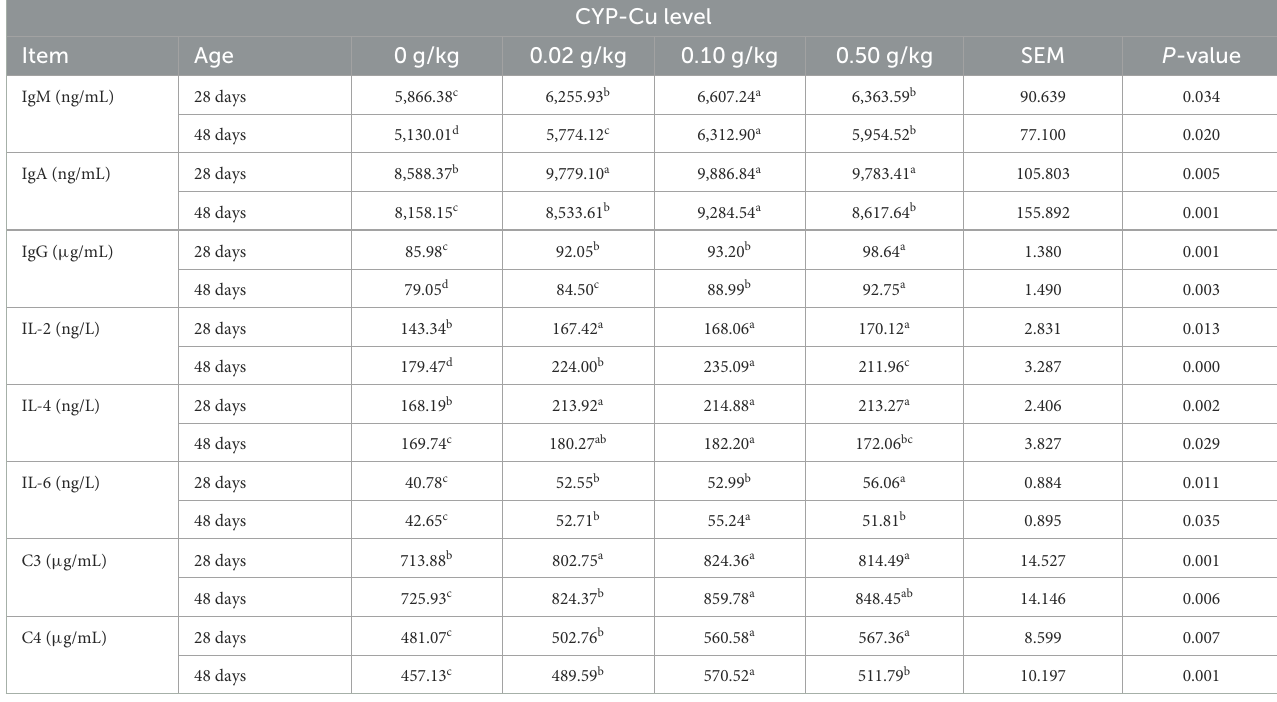
TABLE 6 Effects of dietary CYP-Cu on serum immune parameters in broilers.